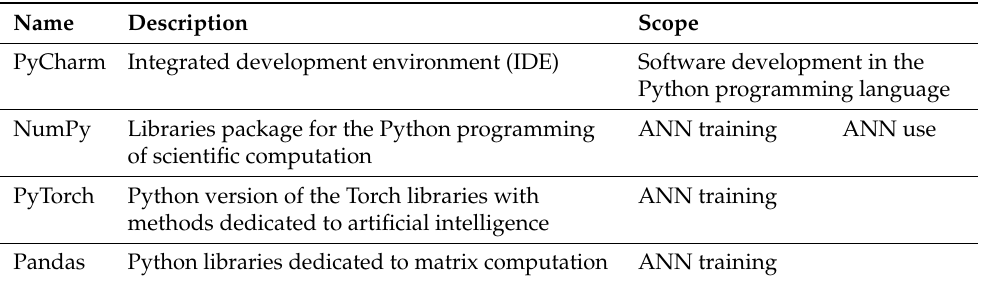
Table 2. The software environment for the development of the “edge AI” ANN (see also Sections 5.2 and